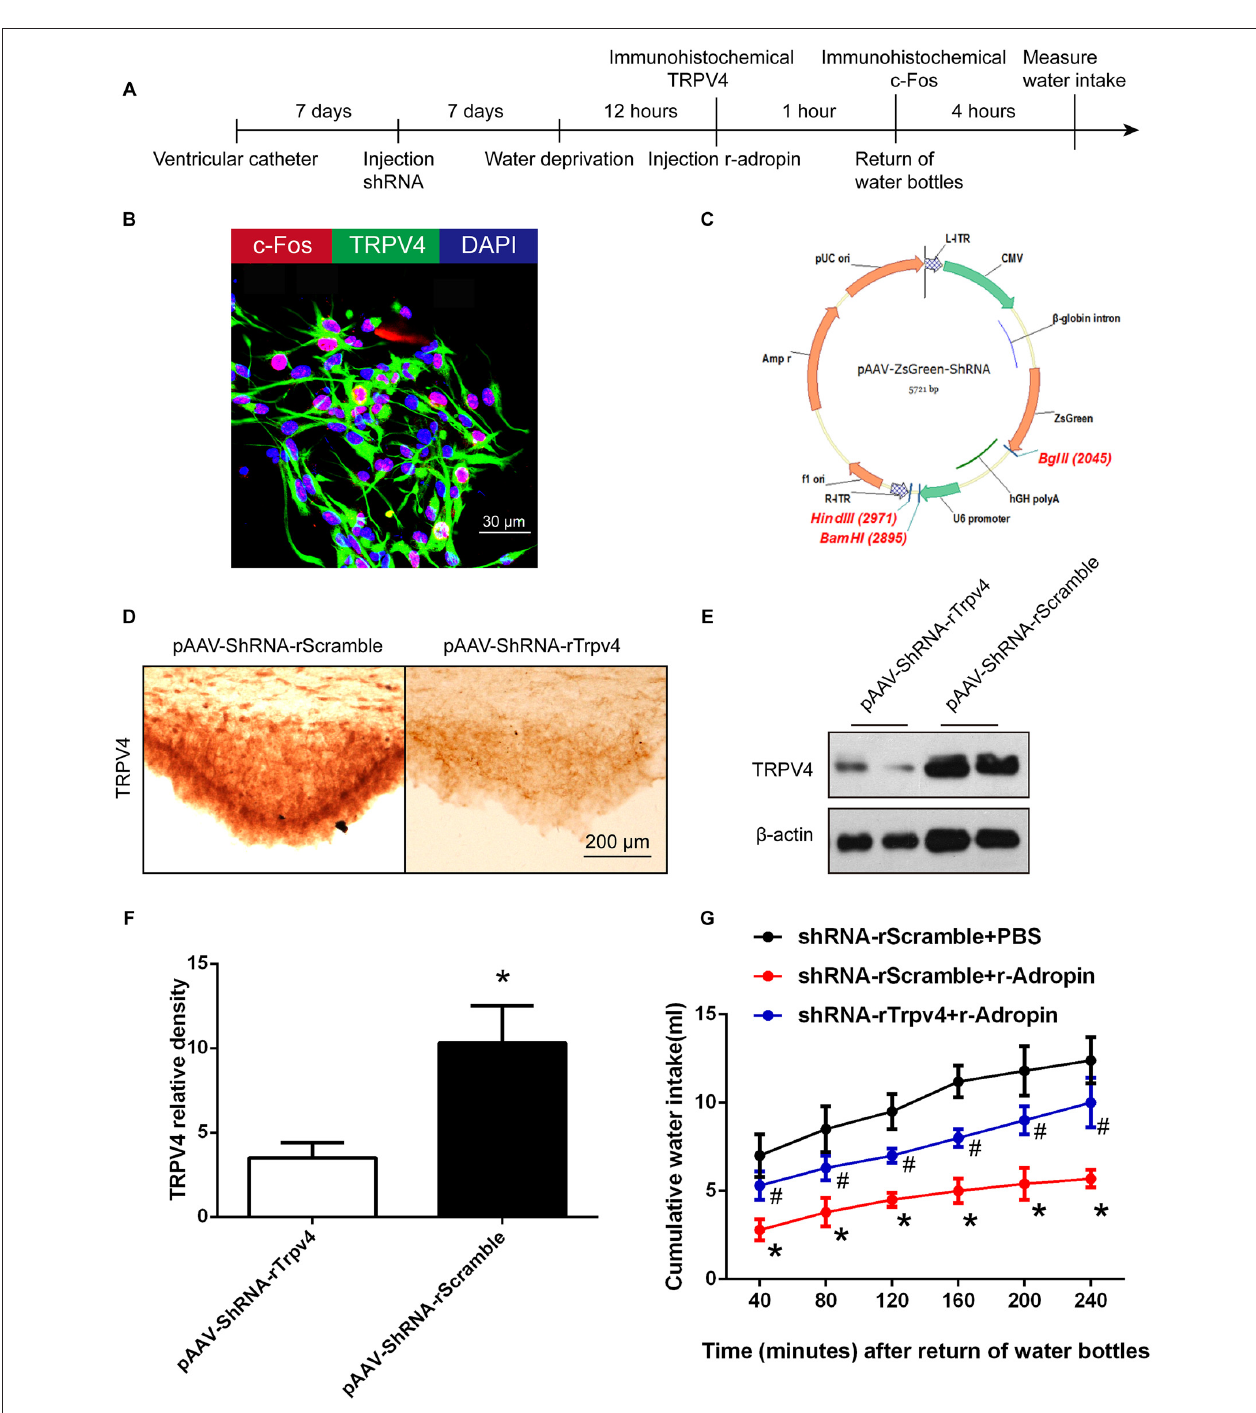
FIGURE 3 | Central administration of recombinant adropin mimicked anti-dipsogenic effects by activating TRPV4 neurons under normoxic condition in SFO. (A) The experimental design to study the mechanism of central anti-dipsogenic effects ( Figures 3 , 4 ). (B) TRPV4 (green) and c-Fos (red) within the same cells in SFO of wild-type rats after water deprivation for 12 h. The right panel shows a magnified view illustrating the overlap between c-Fos and TRPV4 positive signals. Nuclei were counterstained with DAPI (blue). Scale bar, 30 µ m. (C) Construction of pAAV-ZsGreen-ShRNA cloning vector for S. thermophiles . (D) TRPV4 (visualized as brown staining) was down-regulated in SFO 7 days after injection of Trpv4 shRNA into the third ventricle. Scrambled shRNA was used as a control. Scale bar, 200 µ m. (E) TRPV4 in SFO was detected by western blot. (F) Relative protein expression was calculated ( n = 6 for each group, ∗ P < 0.05). (G) Central administration of recombinant adropin (3 nM) inhibited water intake after 1 h and the inhibitory action of adropin was blocked by TRPV4 shRNA after 4 h in overnight water-deprived rats ( n = 8 for each group; ∗ P < 0.05 vs. control group; # P < 0.05 vs. recombinant adropin group).